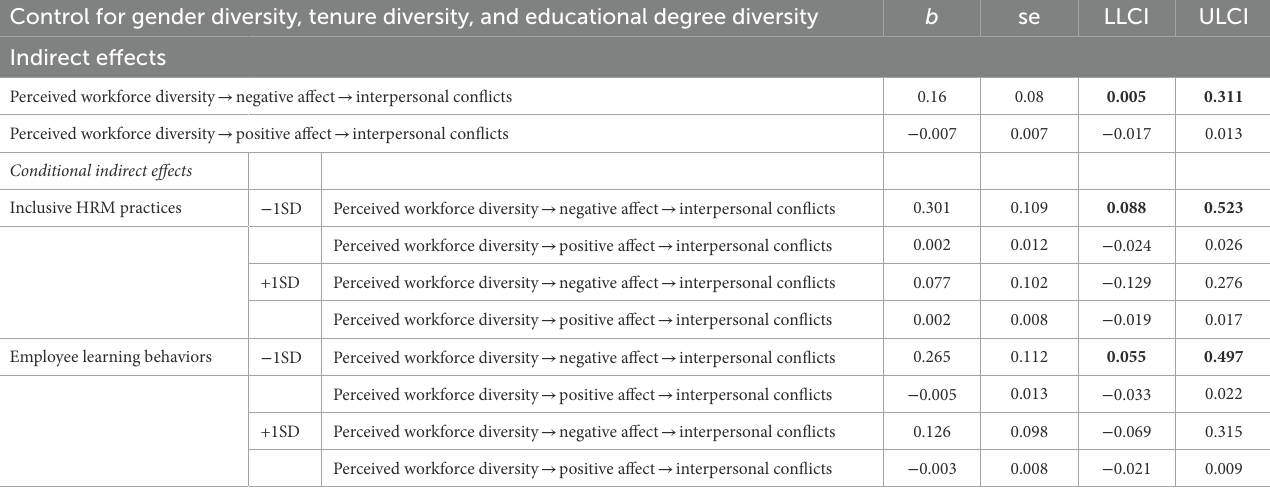
TABLE 3 Process results of indirect effects and conditional indirect effects. Control for gender diversity, tenure diversity, and educational degree diversity b